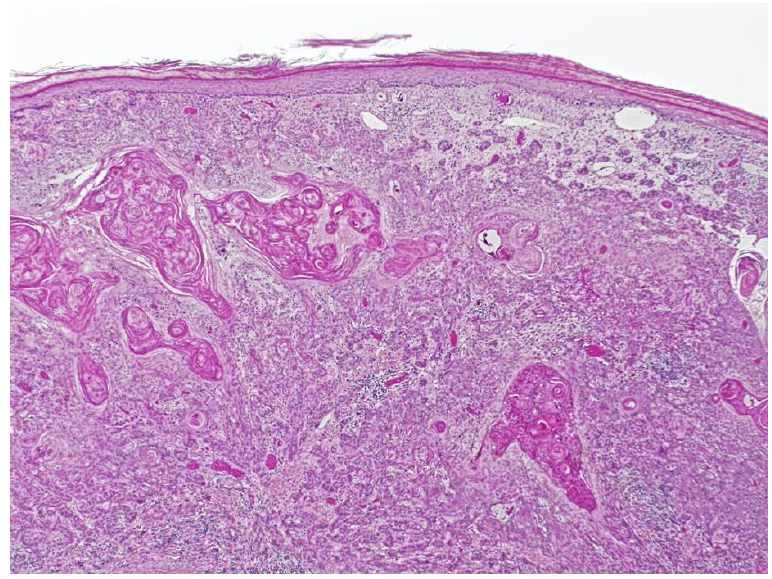
Figure 4. Right ventral hand with 2.4 cm, fissured, indurated, erythematous, ulcerated, and de- pressed plaque.